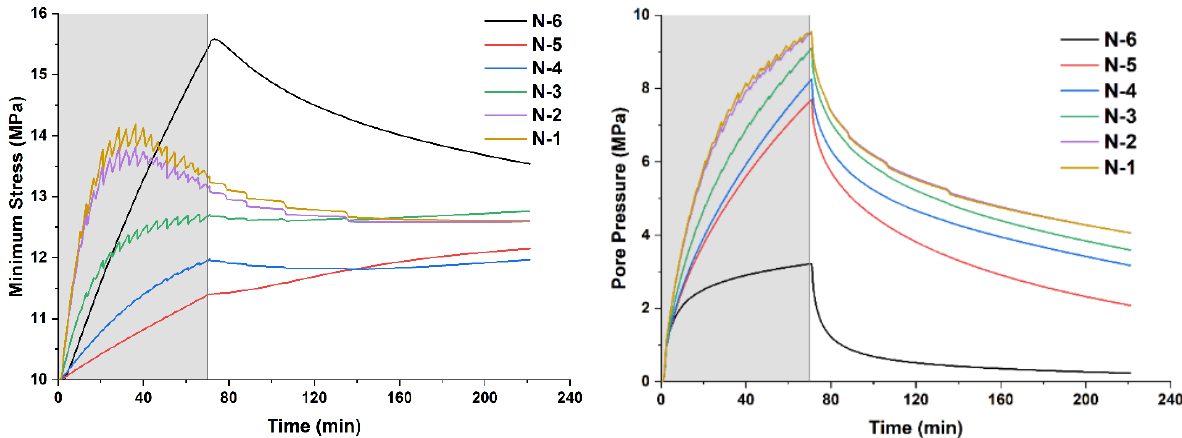
Figure 18. Variation curve of minimum principal stress and pore pressure at monitoring points. The gray area represents the fracturing stage, and the pump stops after 70 min.